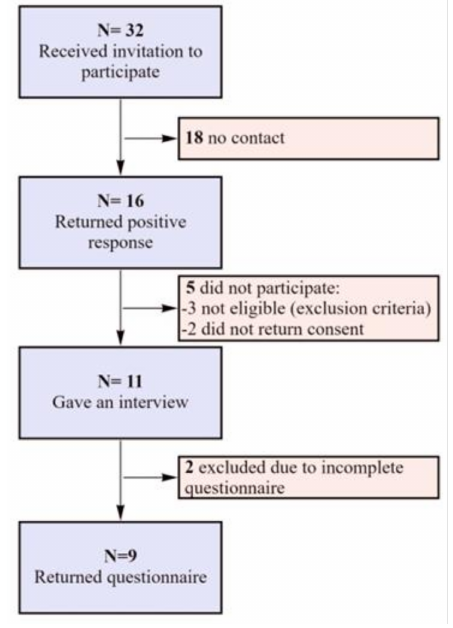
Figure 1. Flowchart of participant enrollment. Table 1. Study respondents’ sociodemographic and health